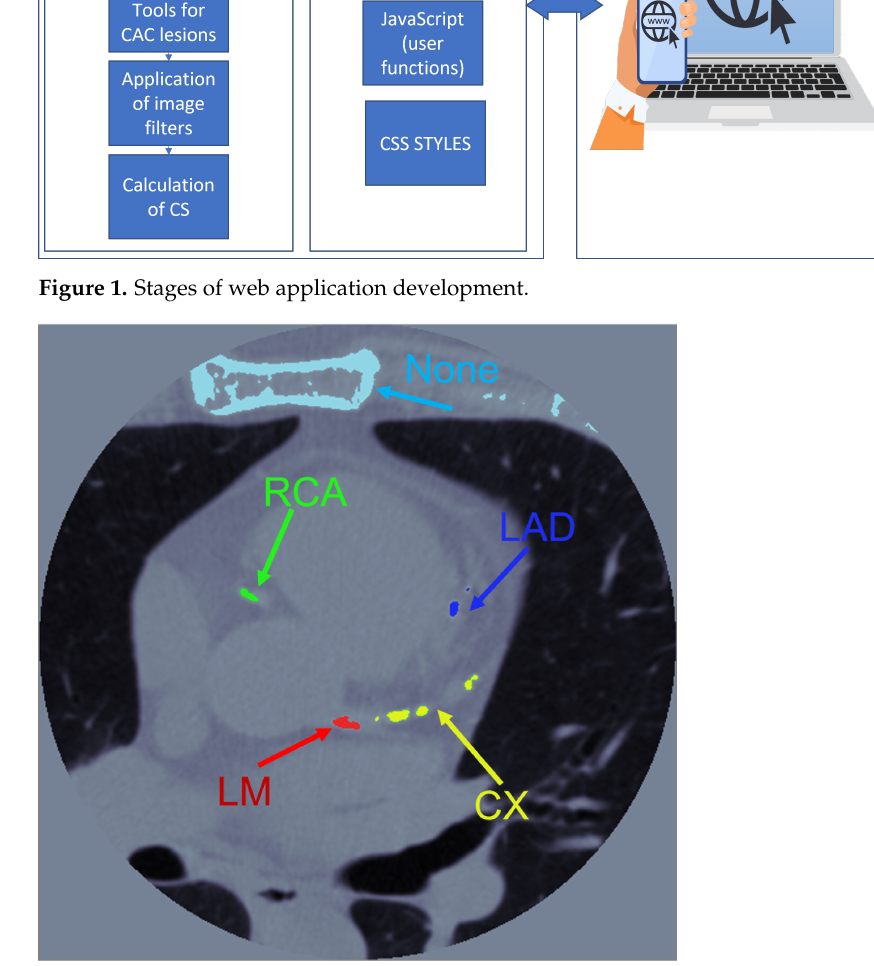
Figure 2. Example of islands of pixels with an intensity greater than 130 HU and their